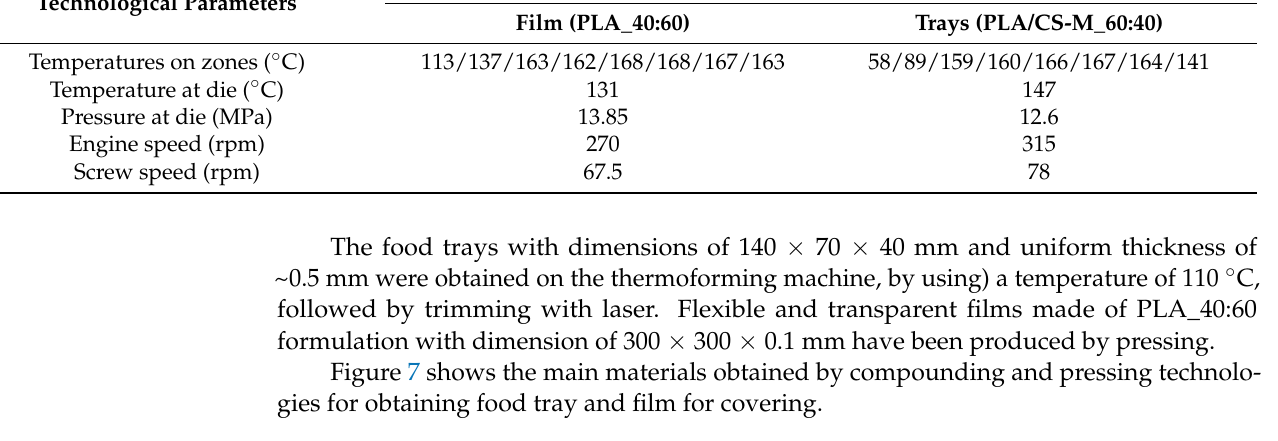
Table 7. Technological parameters for compounding of PLA/CS/M_60:40 and PLA_40:60 formulations.